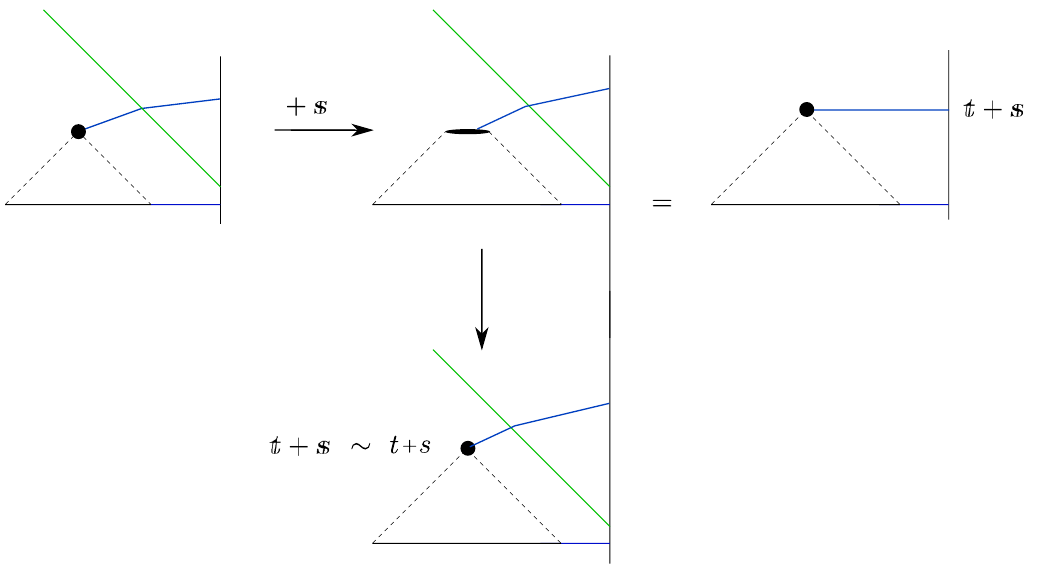
Figure 12 . By modular evolving the operators (cid:8)( X t in the same Cauchy slice. If we Heiseneberg evolve this operator, it is equivalent to the Heisenberg operator (cid:8)( X H ; t + s ) (right). If the point ( X 0 implies that the modular (cid:13)ow is local. That is, (cid:8)( X t (cid:8)( X 0 t + s ; t + s ) B